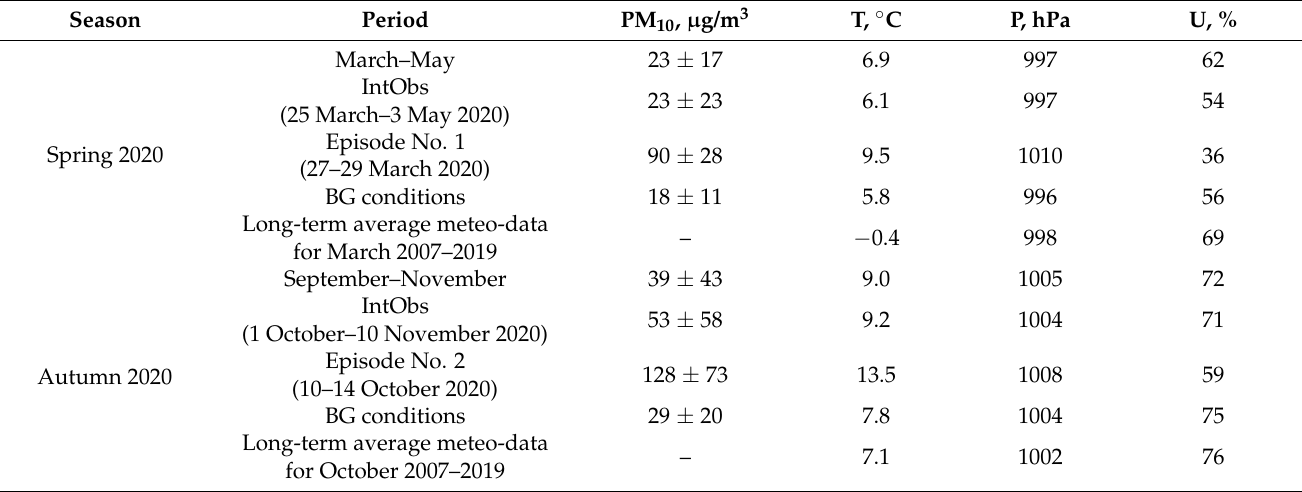
Table 2. Meteorological conditions and aerosol PM 10 concentration ( ± STD) in different seasons: comparison of episodes of extremely high aerosol pollution in near-surface air in Moscow with other periods, the average values through specified periods. The BG conditions were calculated through a period of IntObs excluding the days of the episode or, for the Summer 2021 (episode No. 6), from weekend data of 18 July